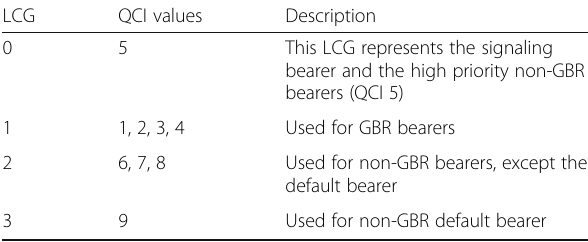
Table 5 QCI-LCG mapping for buffer status reporting